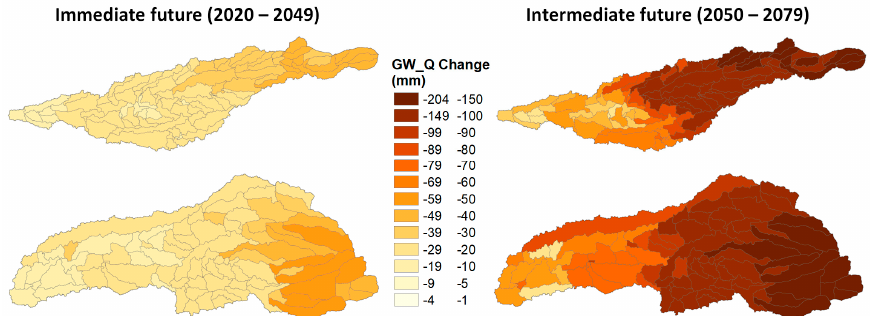
Figure 9. Changes in the yearly average groundwater flow (GW_Q) at the sub-basin scale, using 430 RegCM4-MPI-ESM-MR, scenario RCP8.5.